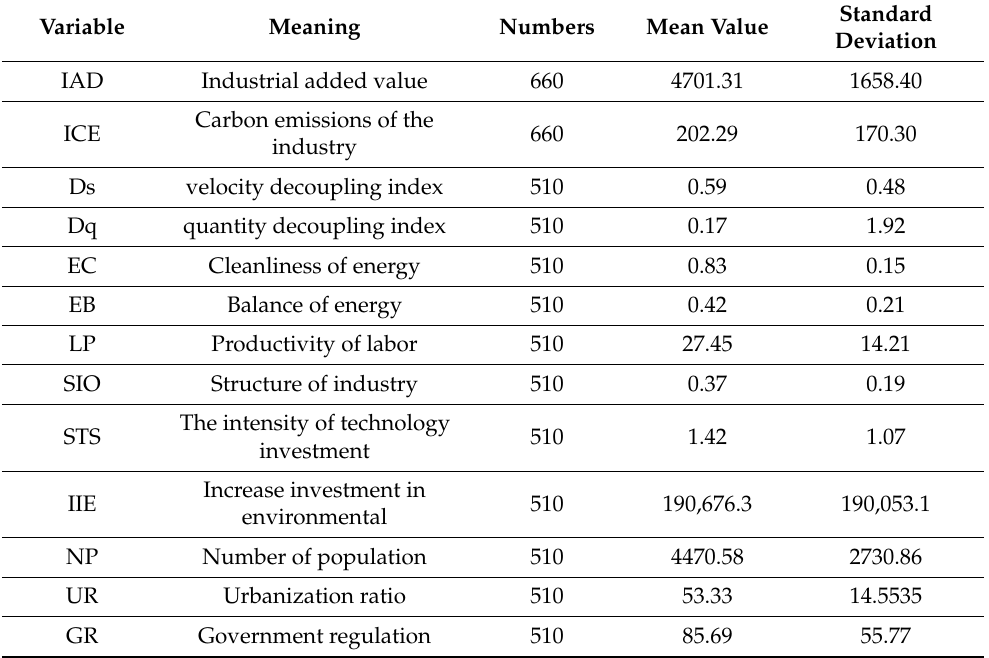
Table 1. Descriptive statistics of